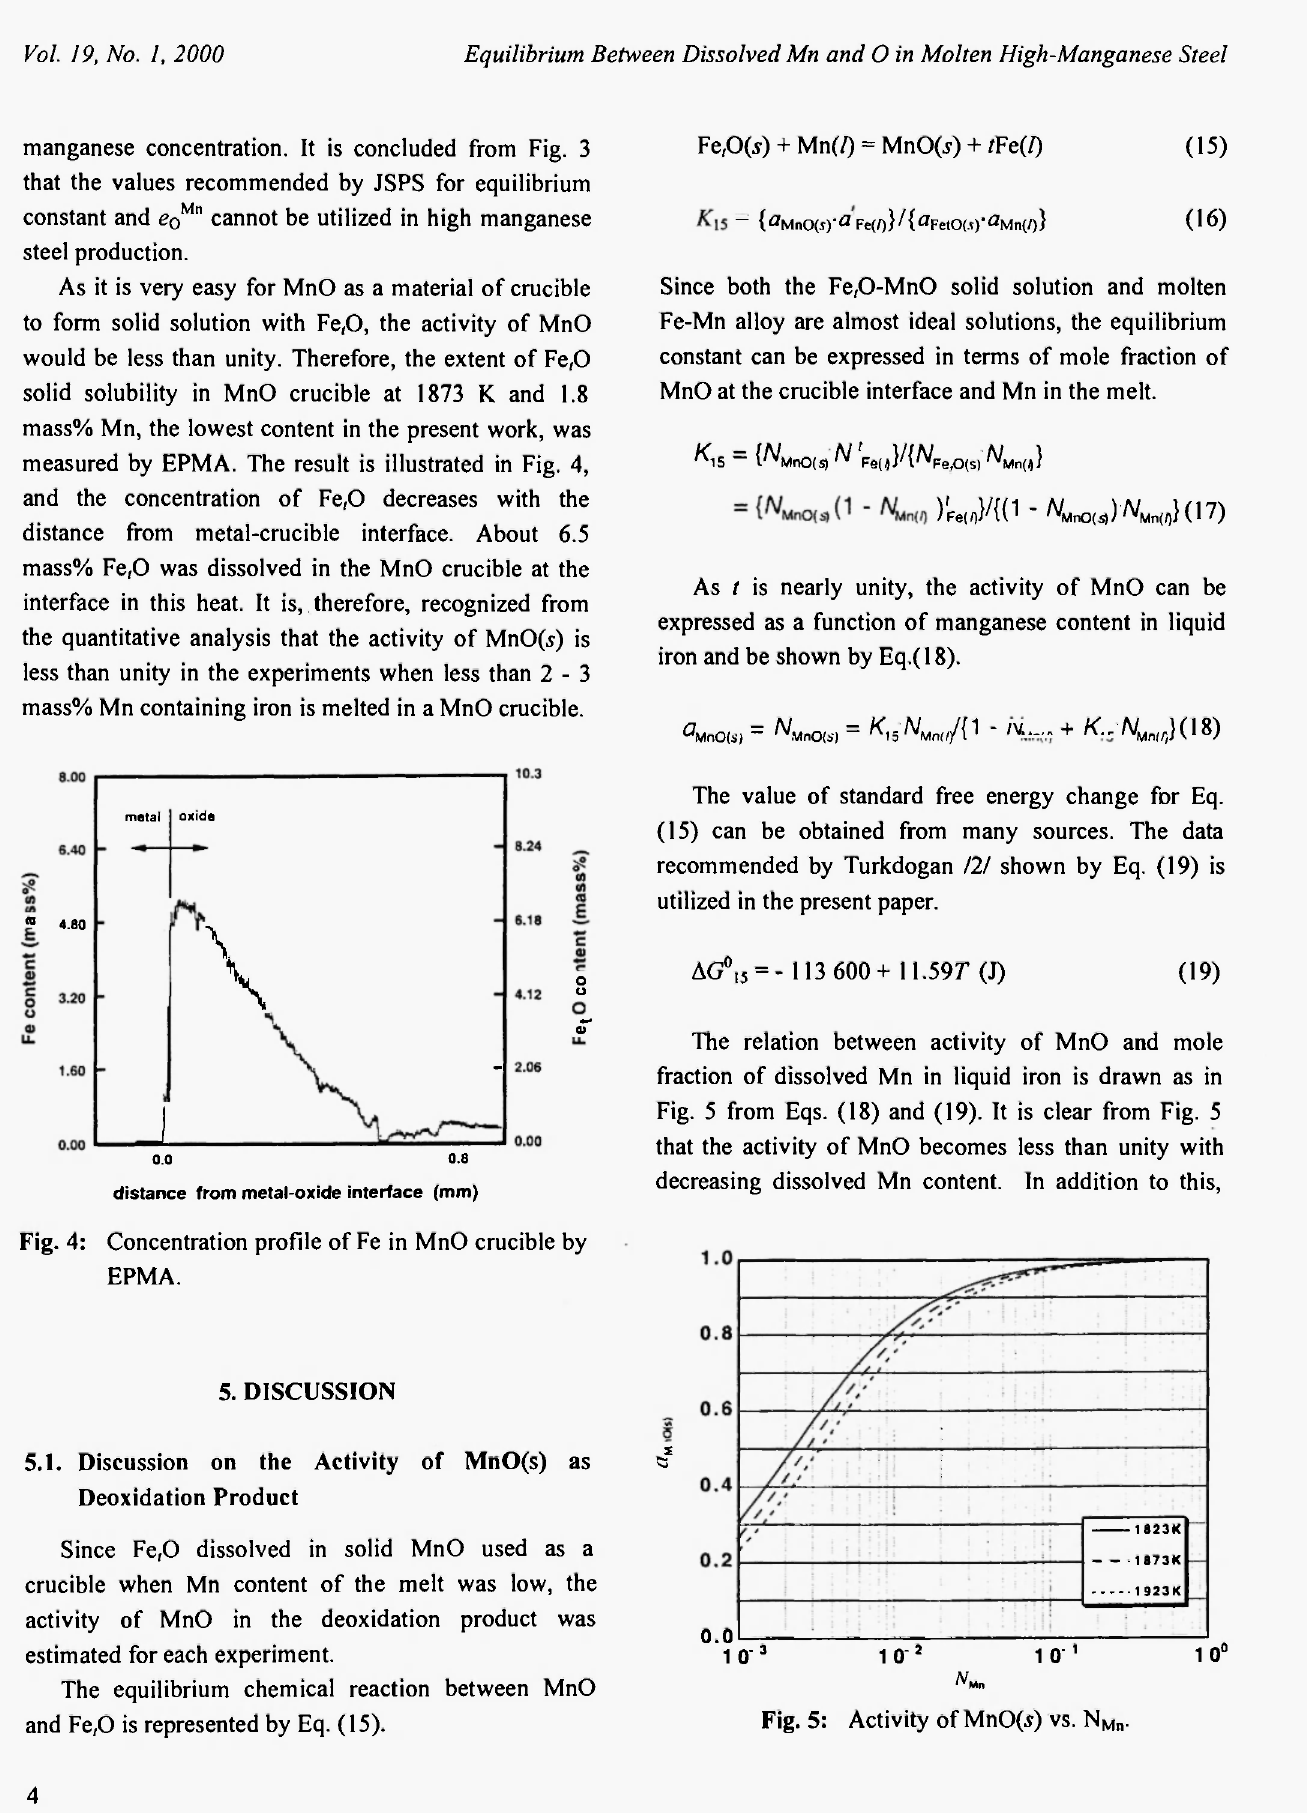
Fig. 4: Concentration profile of Fe in MnO crucible by ΕΡΜΑ.